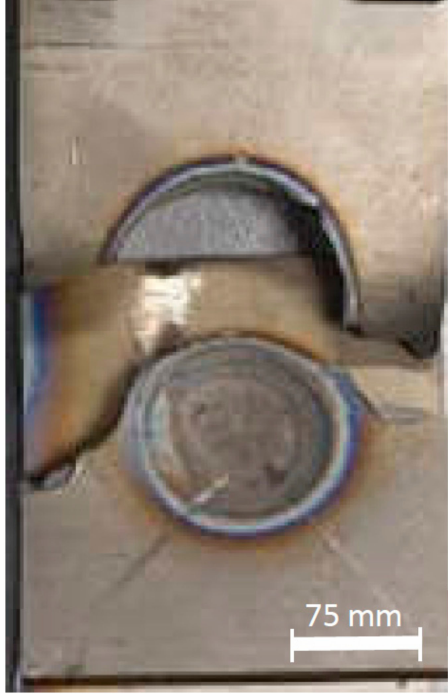
Figure 12. The sample tensile-shear testing failure mode observed by the confirmation